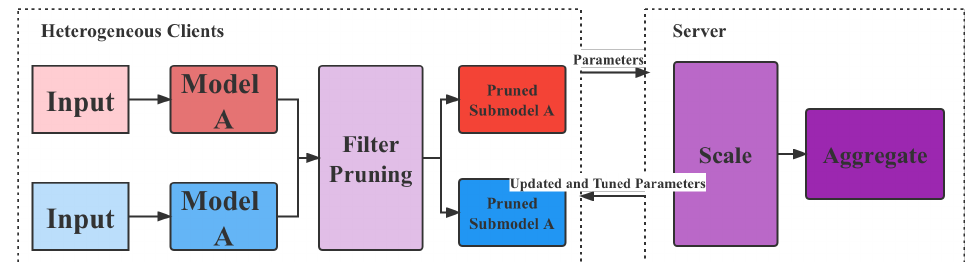
Figure 4. The flowchart of proposed method.